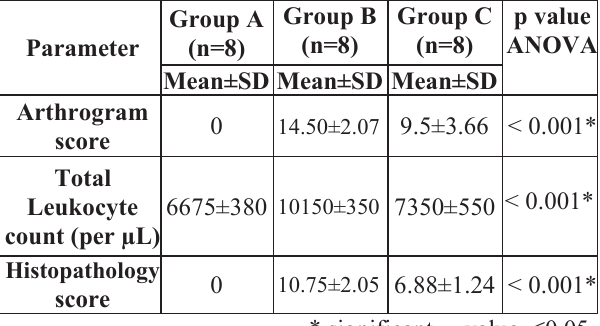
Table-1: Intergroup comparison of arthrogram score, total leukocyte count and histopathology score on day